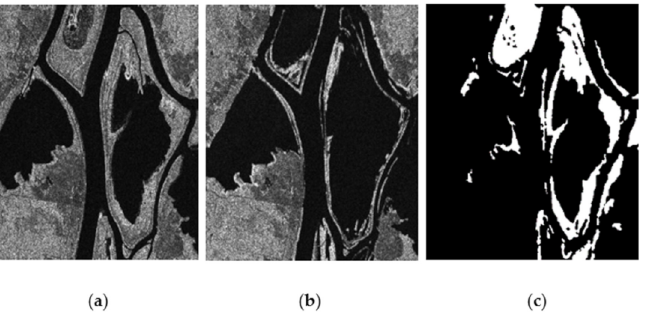
Figure 10. Ottawa dataset with a 10-m resolution. ( a ) Image acquired in May 1997. ( b ) Image acquired in August 1997. ( c ) Ground truth.